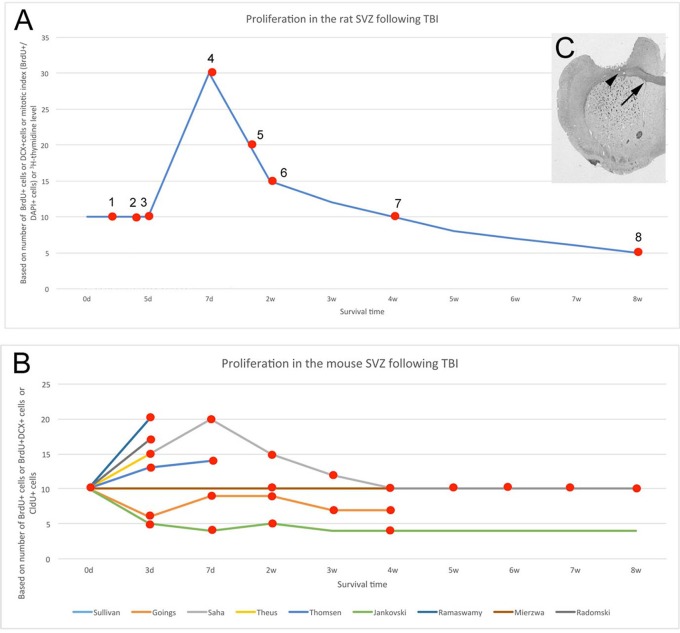
Altered SVZ proliferation is variable across species and experiments. (A) Increased SVZ proliferation and/or neurogenesis in rat after mechanical injury to brain. Data from multiple studies. 1 - (Tzeng and Wu, 1999), 2 - (Goodus et al., 2015), 3 - (Gotts and Chesselet, 2005), 4 - (Szele and Chesselet, 1996; Sun et al., 2009, 2010; Bye et al., 2011), 5 - (Weinstein et al., 1996) 6, 7 - (Bye et al., 2011; Grande et al., 2013), 8 - (Acosta et al., 2013, 2014). For both (A,B), baseline was set at a value of 10 and percent changes from this are shown. (B) SVZ proliferation or neurogenesis in mouse after mechanical injury across multiple studies. Individual studies shown with colored lines (Jankovski et al., 1998; Goings et al., 2002; Ramaswamy et al., 2005; Theus et al., 2010; Radomski et al., 2013; Saha et al., 2013; Sullivan et al., 2013; Mierzwa et al., 2014; Thomsen et al., 2014). The Saha et al., study was the most complete including time points at 3 days, 1, 2, 3, 4, 5, 6, 7, and 8 weeks post-lesion. (C). Cortical injury via aspiration. The injury excludes the corpus callosum (arrowhead) but is close to the subventricular zone (arrow). Aspiration lesions of the cerebral cortex were made in the same location both in mouse and rat (Szele and Chesselet, 1996; Goings et al., 2002, 2004).